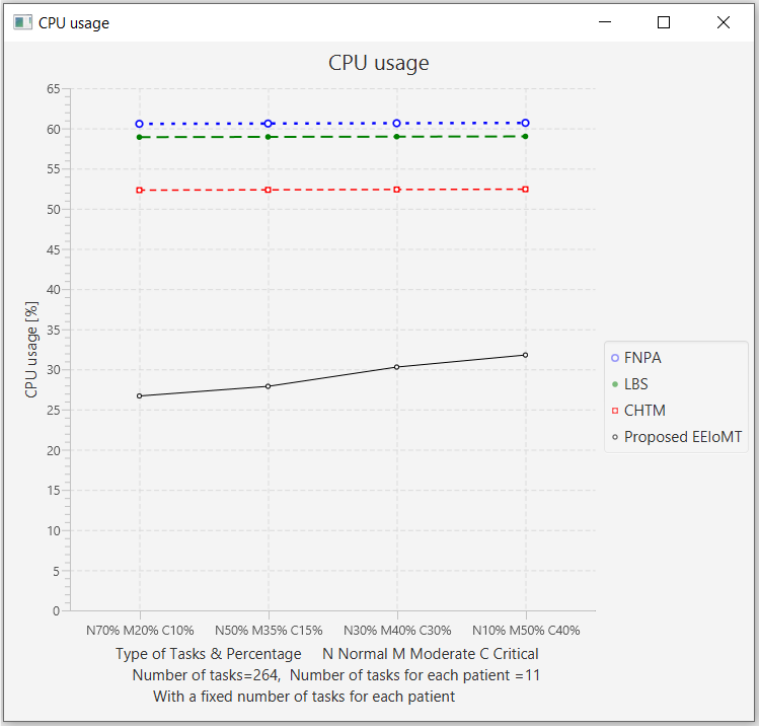
Figure 26. Network usage comparison when changing the percentage of each type of task.